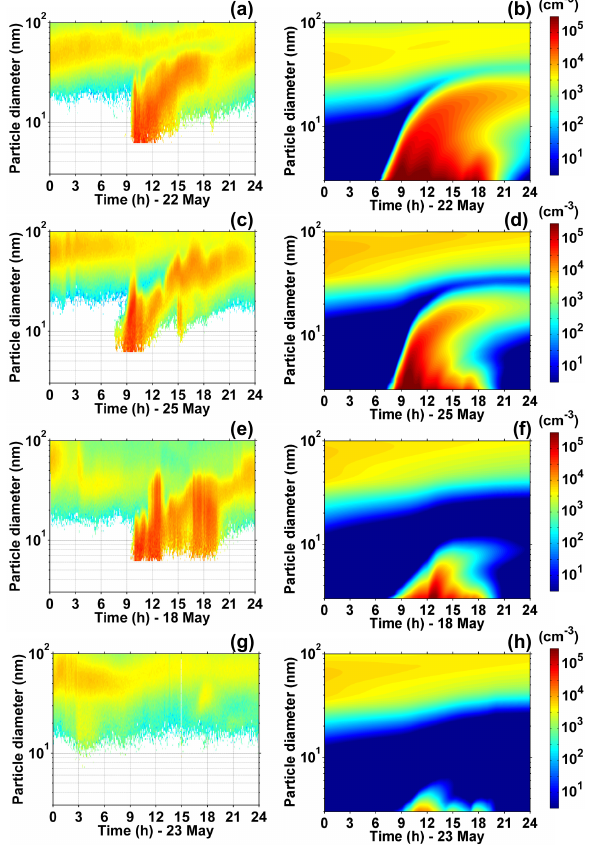
Fig. 8. Example particle number size distribution [cm − 3 ], expressed as d N /dLog D p from measurements (a, c, e, g) and as simulated by the UHMA (b, d, f, h) during the NIFTy experiment. The reported days are representative of (a–b) an event class A and (g–h) a non- event day showing good model skill, (c–d) an event class A and (e–f) an event class C day in which particle growth is not captured by the model. Model simulations have been performed setting 250 sections in order to match the size resolution of the SMPS.